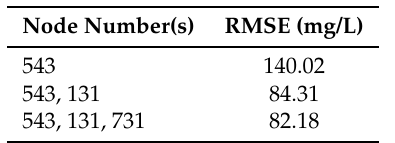
Table 1. Effective sensor placements for 3 sensors by minimizing